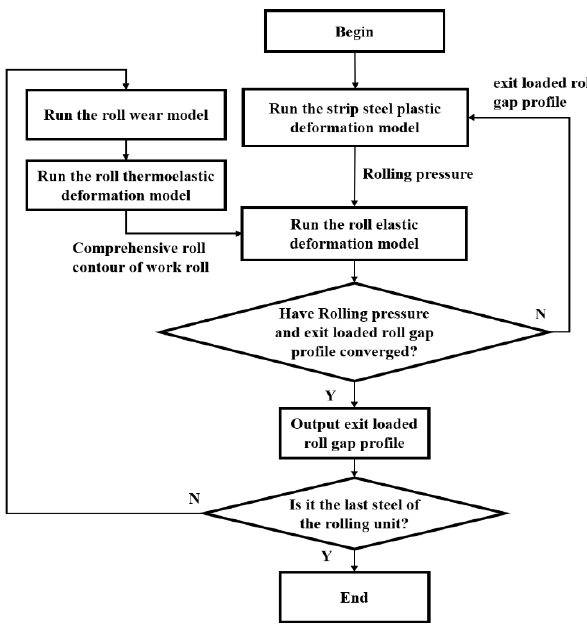
Figure 5. Calculation process of rolls-strip integrated model.